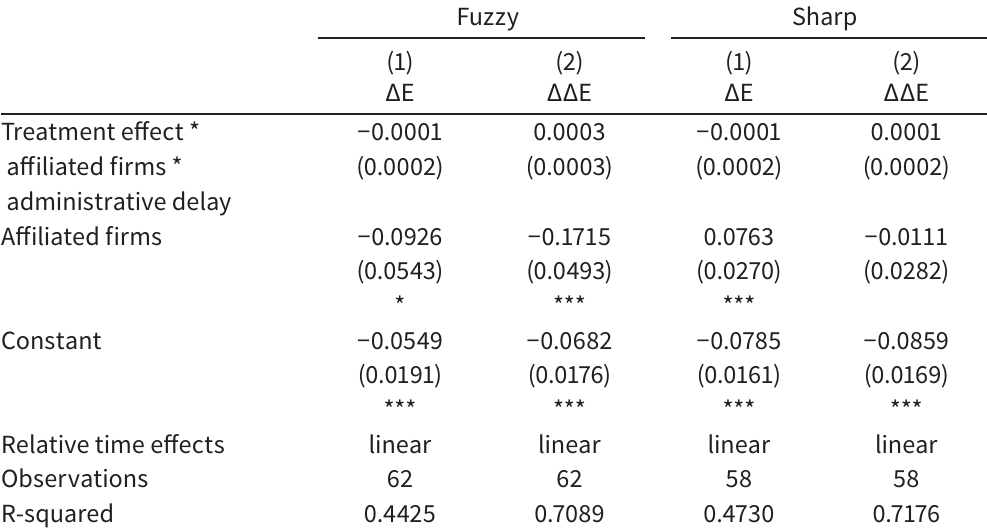
Panel B. Results on the role of retroactivity by affiliation